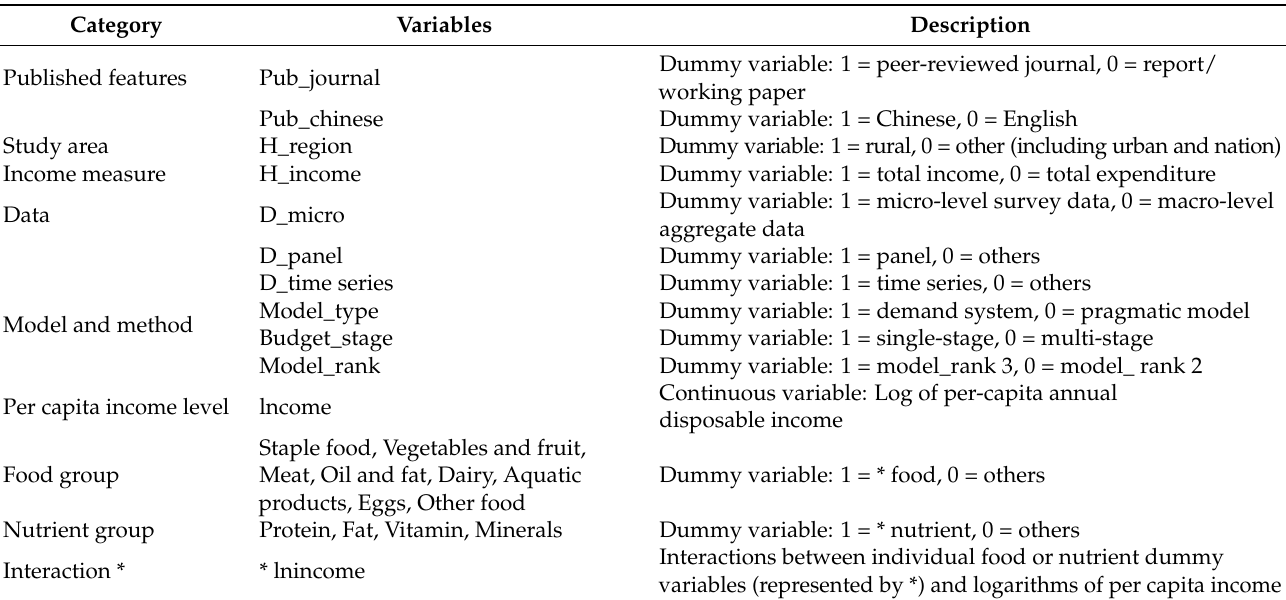
Table 2. Description of the